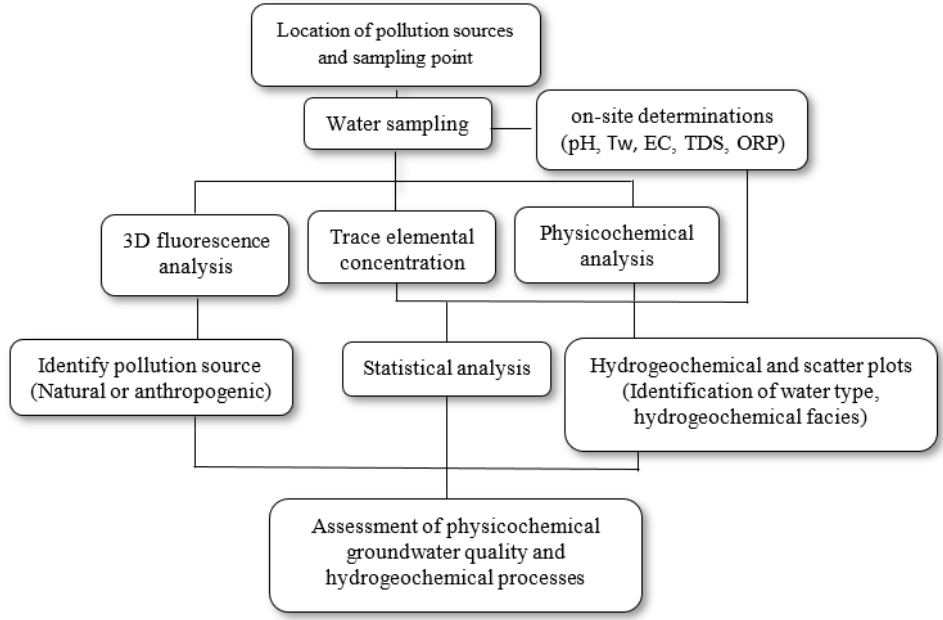
Figure 2. Flow diagram of the methodology used to determine water quality in the study area.